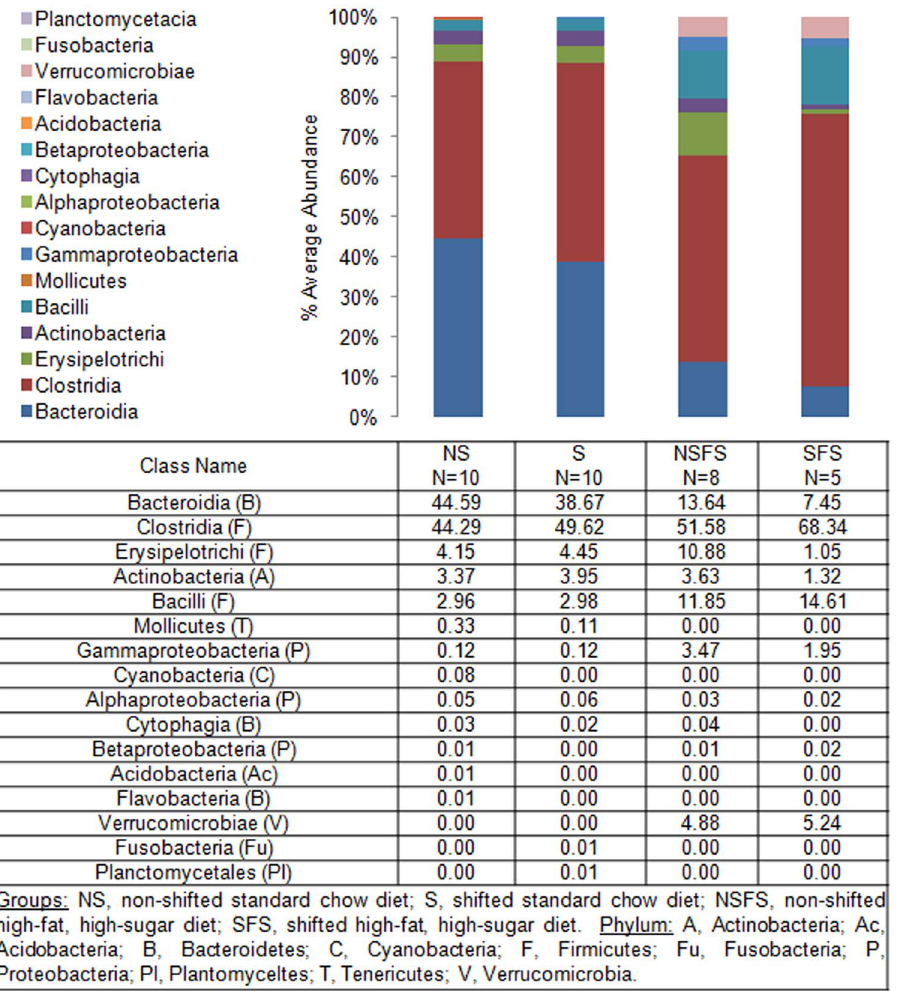
Figure 4. Mouse gut microbial community structure at the class level. The bar graph graphically represents the average relative abundance of classified bacteria SSU rRNA gene amplicons belonging to the most abundant taxon at the class level.